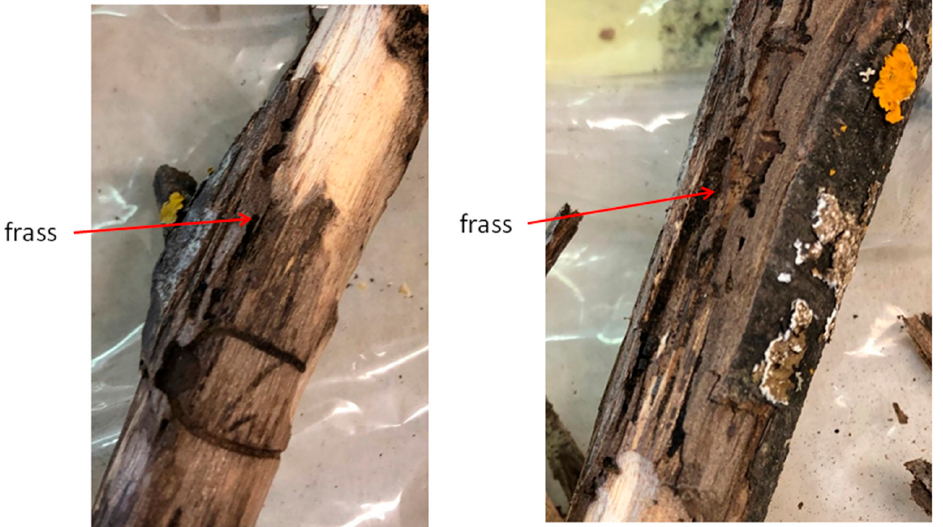
Figure 6. Black walnut branches infested by P. juglandis with an indication (red arrows) of the frass sampling sites.